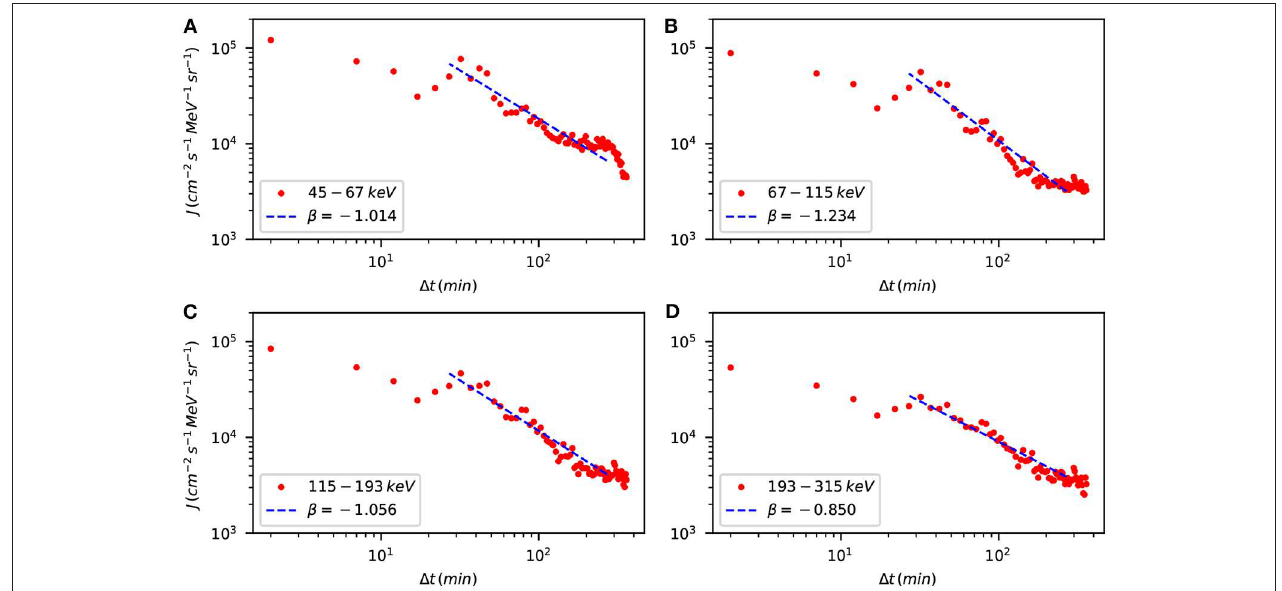
FIGURE 6 | Power-law fits (dashed lines) of the measured energetic particle fluxes (red dots) in several energy channels, see legends, for the shock crossing of 26 August 1998. The exponent of power-law fit is indicated in each legend. The panels correspond to the energy channels (A) 45–67 keV, (B) 67–115 keV, (C) 115–193, and (D) 193–315